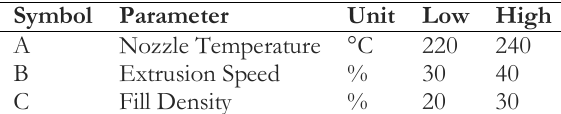
Table 2. 3D printer parameters and their levels.